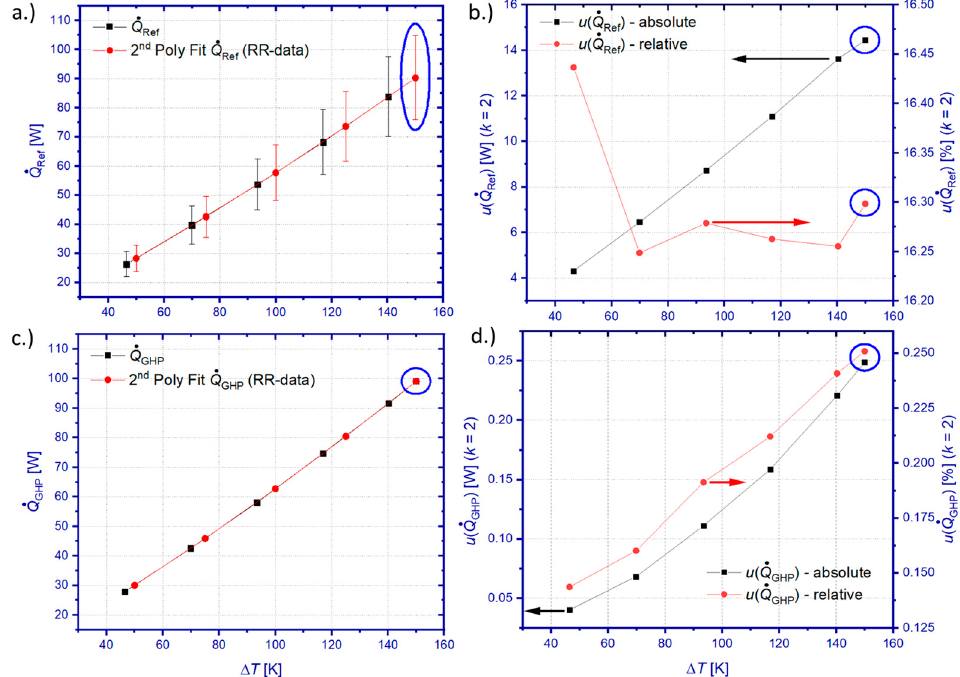
Figure 6. Heat flow measurement results (best estimates) of the reference principle ( a ) and the guarded hot plate ( c ) in dependence on ∆ T . Combined uncertainties of heat flow determination ( k = 2) are displayed as absolute and relative values for the reference principle ( b ) and the guarded hot plate ( d ). For details on the determination of uncertainties refer to Supplementary Information S3. In order to achieve comparability of RR heat flow results, DLR data were interpolated for ∆ T = 50, 75, 100, and 125 K and extrapolated for ∆ T = 150 K. Parabolic fits have been used for the approximation . . . . Q Ref ) and u ( Q GHP ) and heat flow results Q Ref and Q GHP . Extrapolated values of of uncertainties u ( these fits are indicated by blue